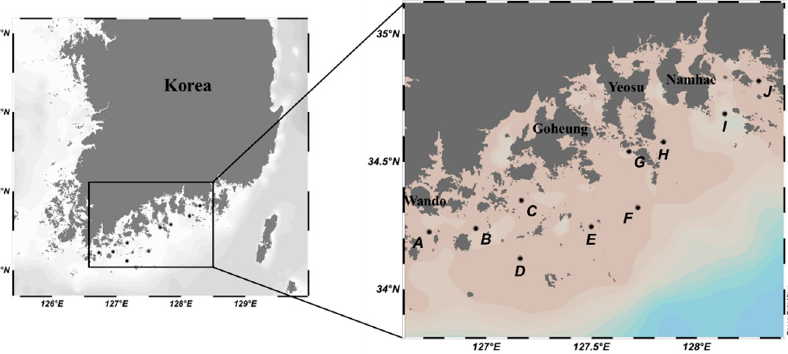
Figure 1. Sampling sites for the metabarcoding analysis of C. polykrikoides bloom in the Southern Korean coastal waters.